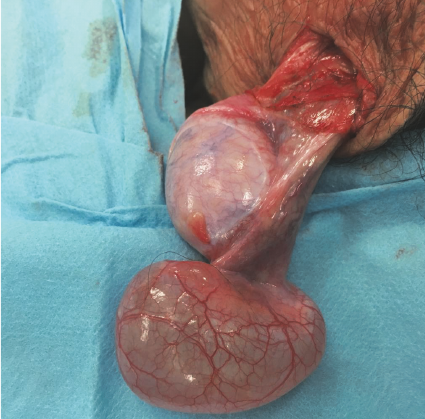
Figure 1: Surgical image of EC adjacent to the left testis.